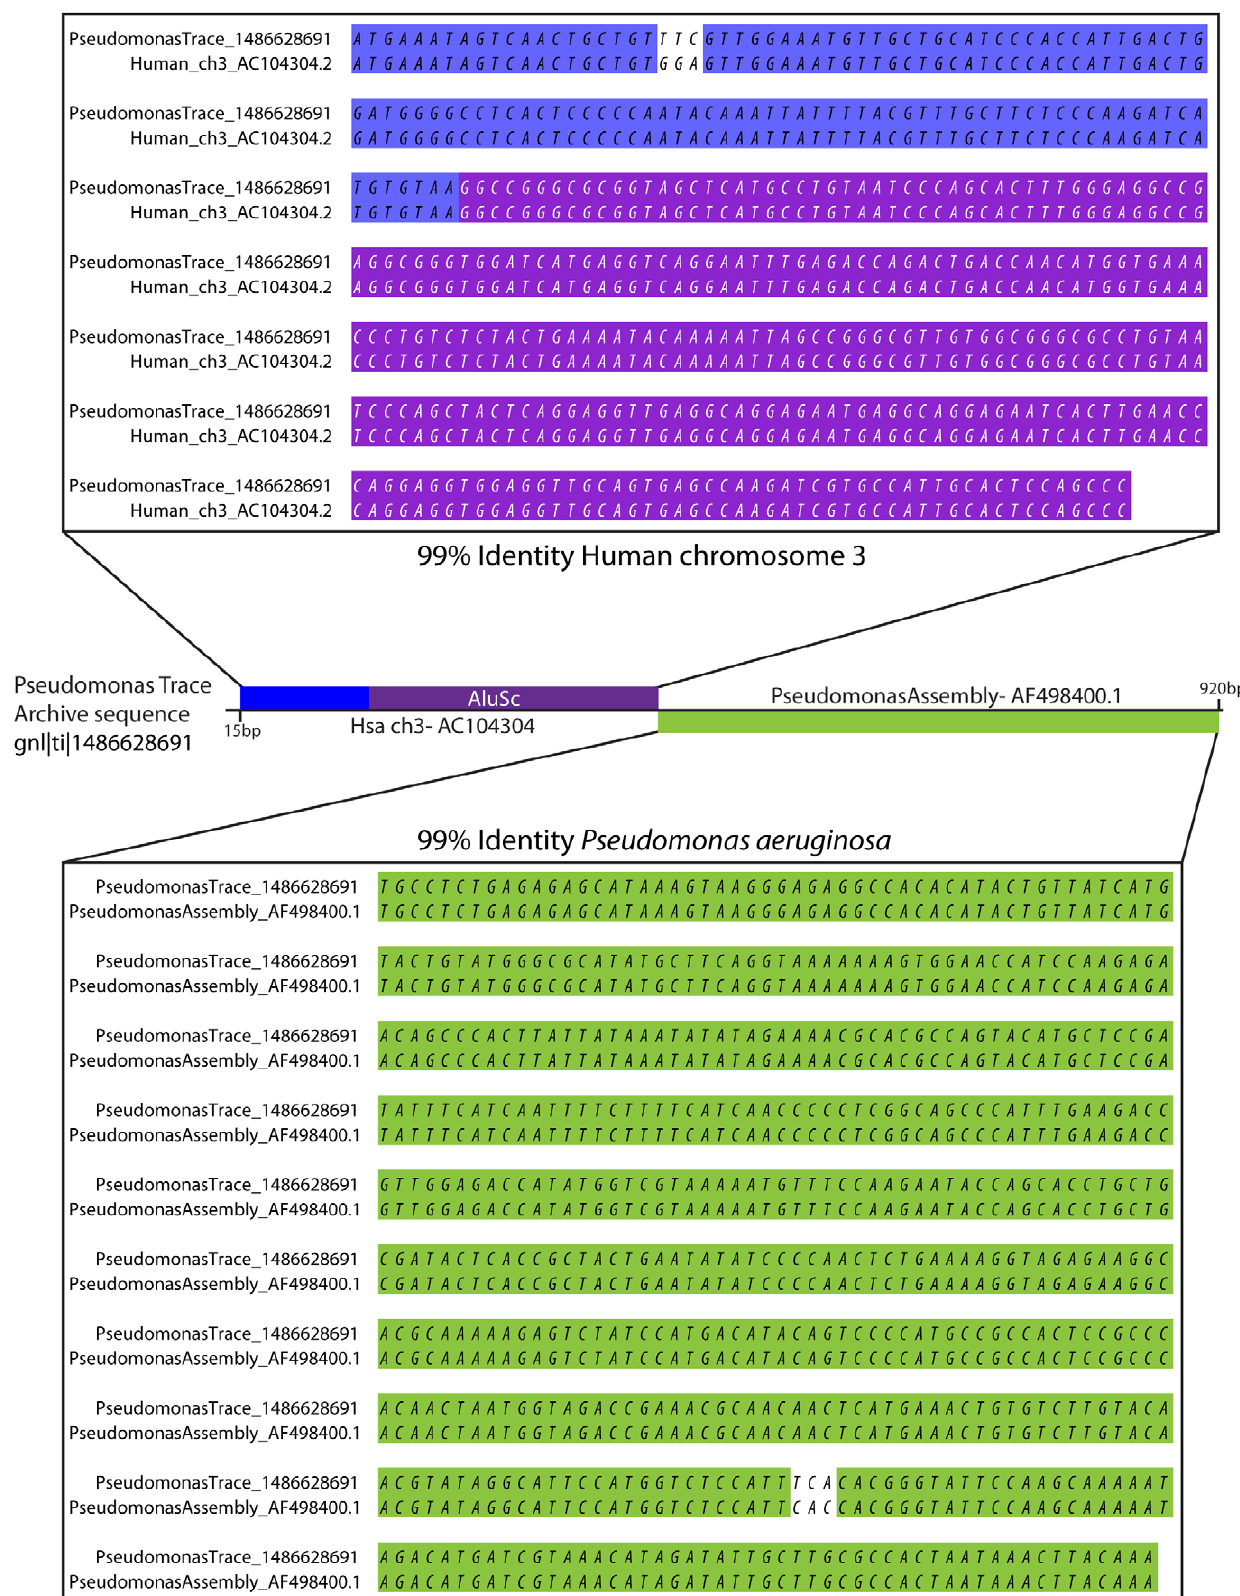
Figure 2. Chimeric NCBI Trace Archive read containing both Pseudomonas and human sequence. Approximately one half of this 920 bp sequence entry is . 99% identical to human (blue and purple) while the other half is . 99% identical to Pseudomonas aeruginosa (green). The Alu alignment used to identify this sequence is shown in purple.